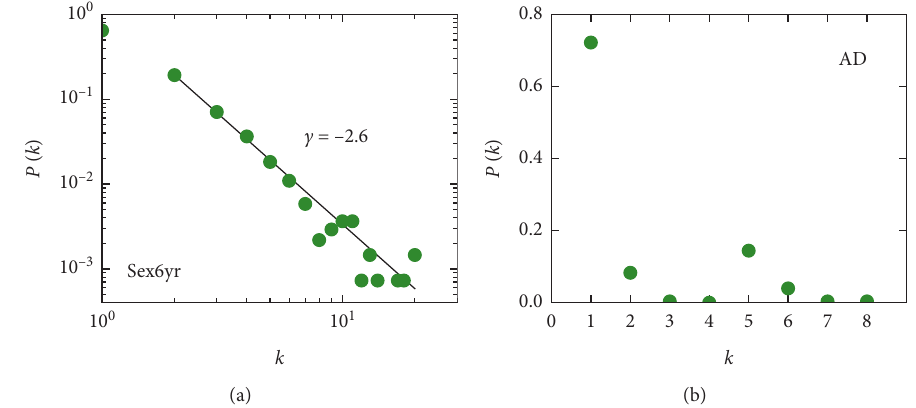
Figure 3: (a) Degree distributions P ( k ) at each time step in an empirical dataset and (b) degree distribution P ( k ) at each time step in the activity-driven (AD) model [22] (to be described in Section 5.1) with s � 5 and N � 1000, and node activity x i is sampled from F ( x i ) ∝ x − ] i with ] � 2 . 1, 10 − 2 ≤ x i ≤